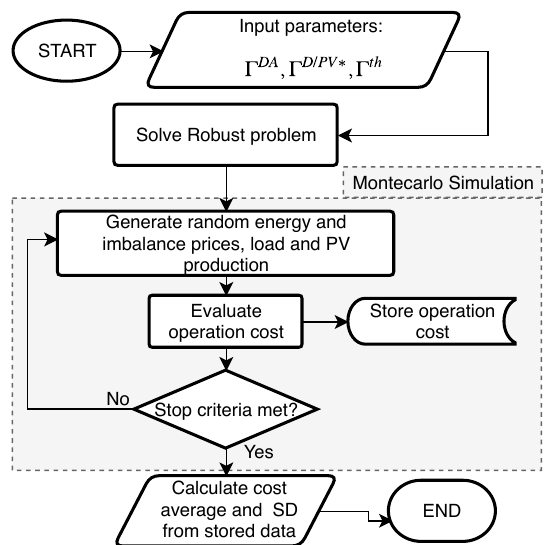
Figure 7. Performance evaluation procedure for predefined values of robust parameters Γ DA , Γ D / PV ∗ , Γ th . * Γ D is valid for the unified approach, and Γ PV is valid for the separated